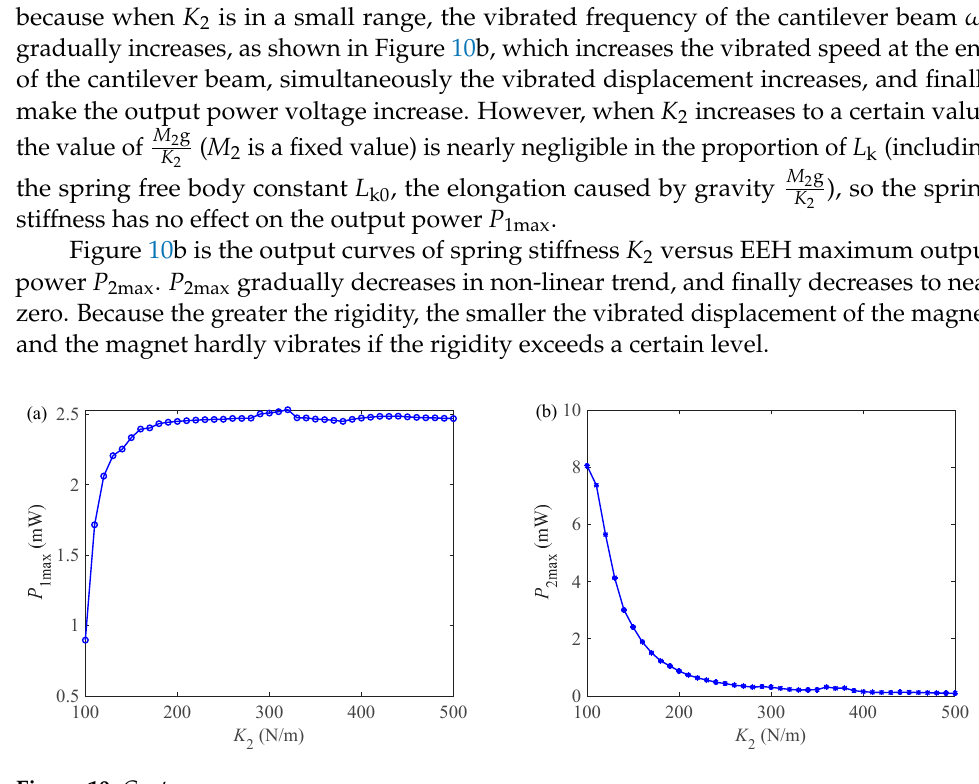
Figure 9. Comparison of effective output power between GPEEH and CGPEH.